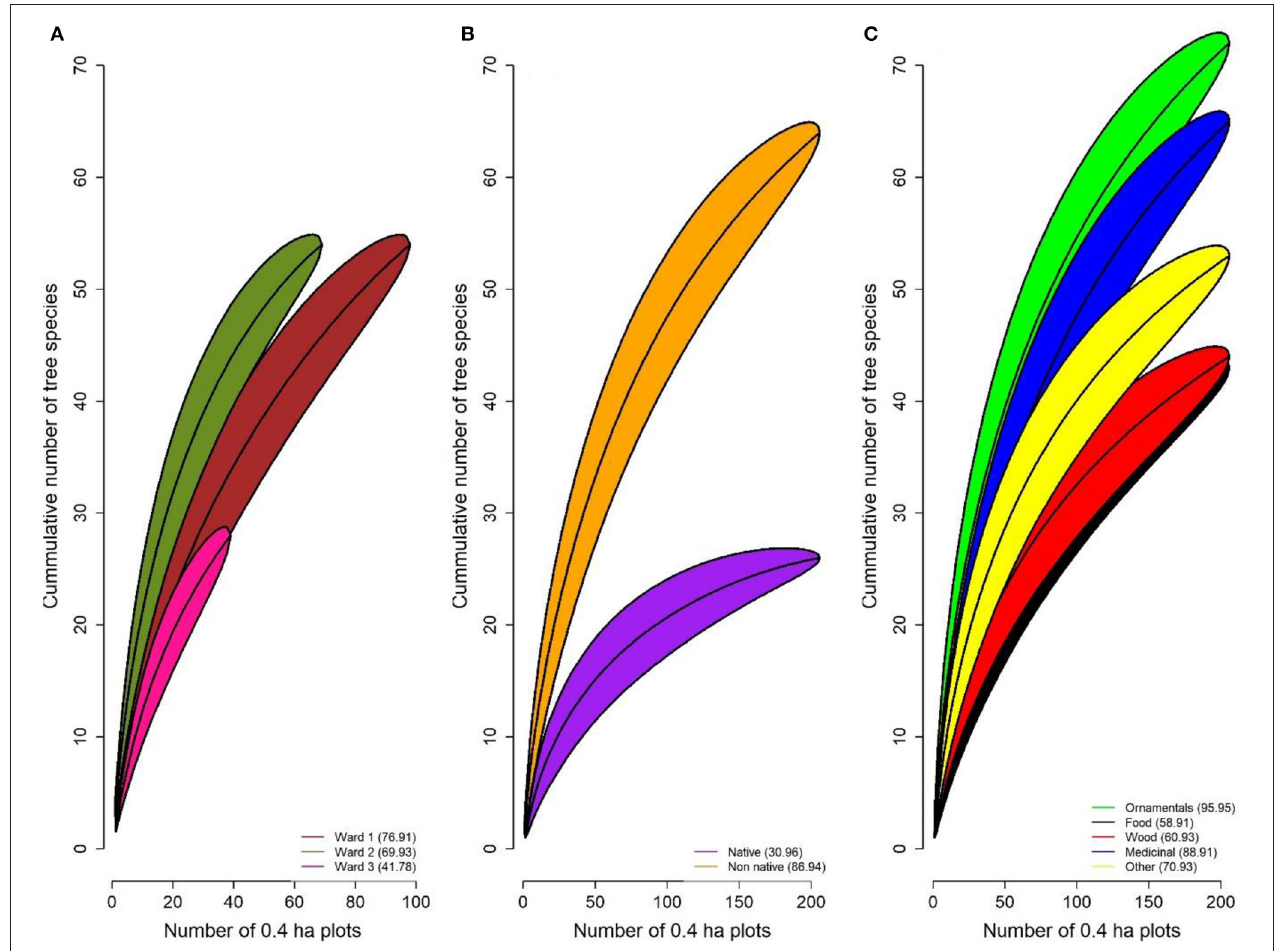
FIGURE 3 | Rarefaction for curves using 1st jackknife estimators to evaluate differences among (A) wards, (B) native vs. non-native species, (C) plant uses.